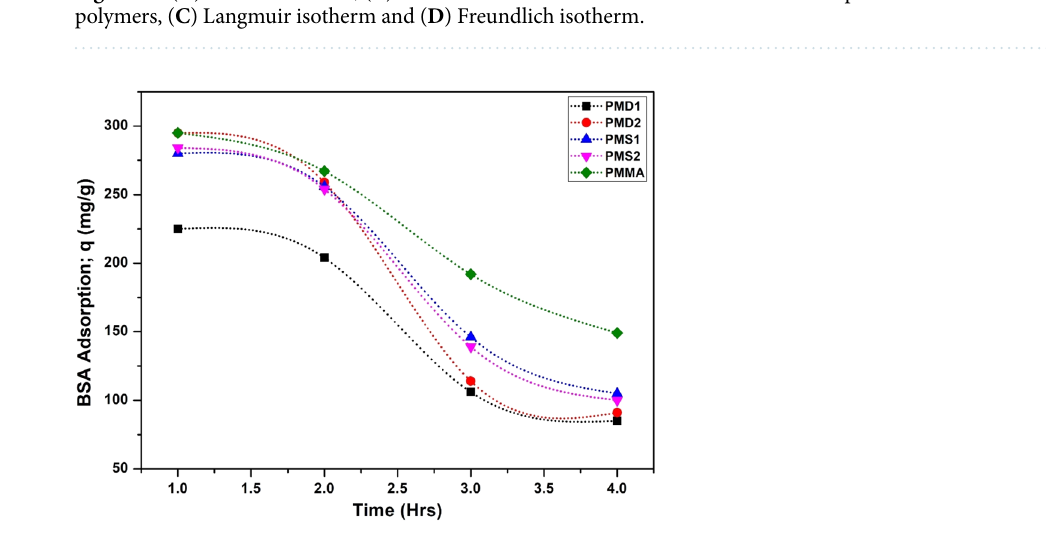
Figure 9. BSA adsorption on the surface of polymers with